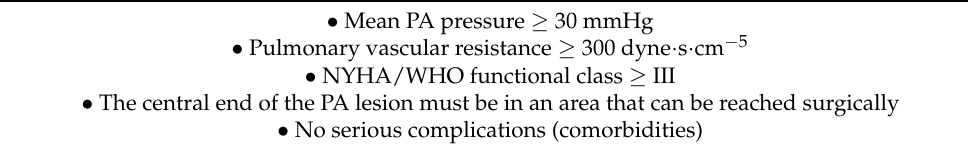
Table 2. Indication Criteria for PEA.